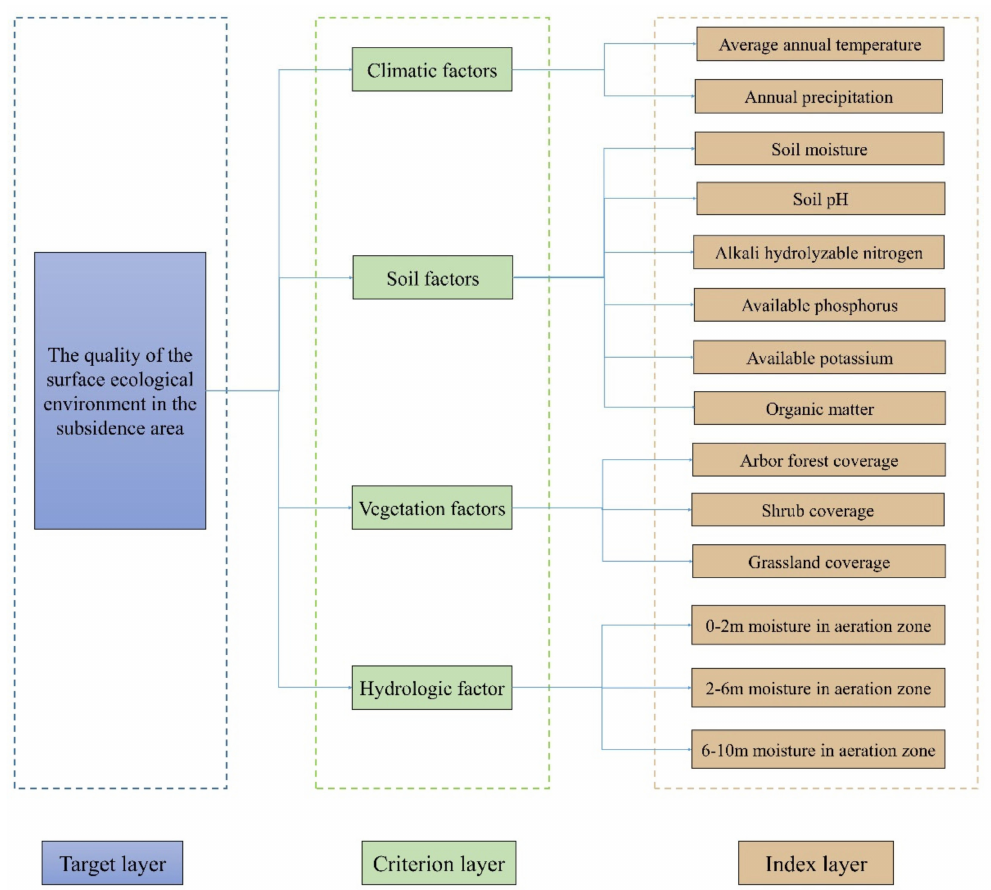
Figure 4. The AHP hierarchy model